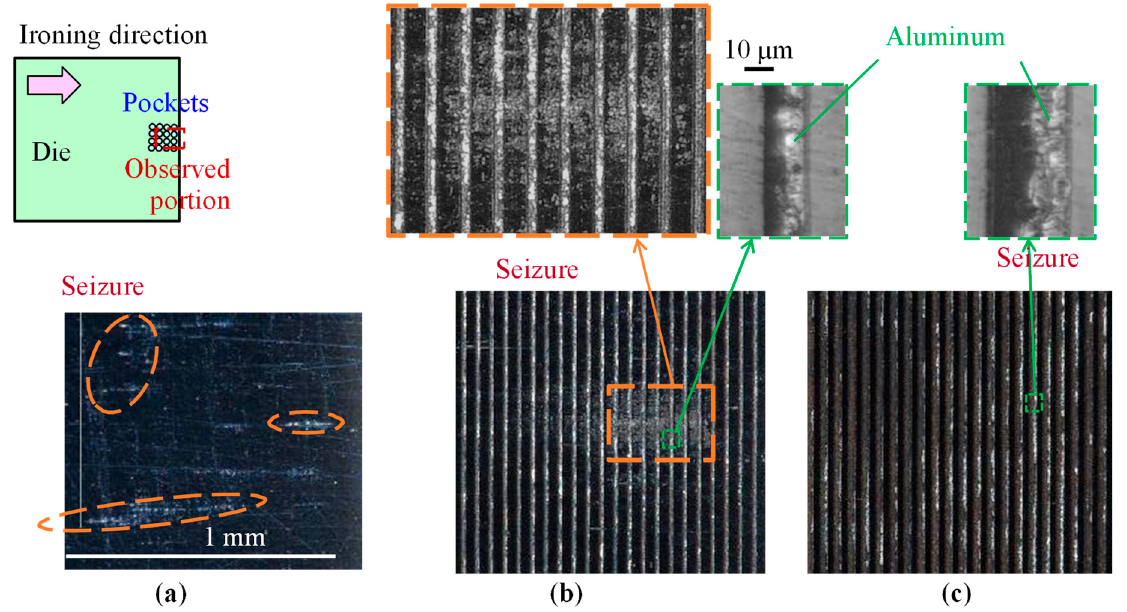
Figure 14. Occurrence of seizure on die with ( a ) smooth surface at r = 15% and with grooved array